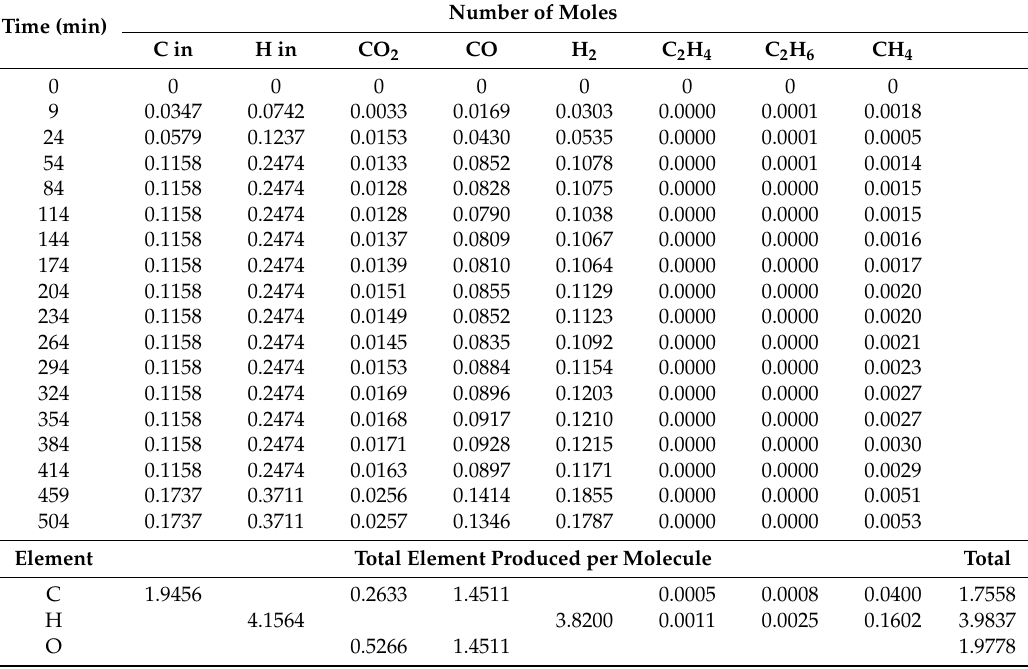
Table 8. Moles calculated for each molecule at each time t .